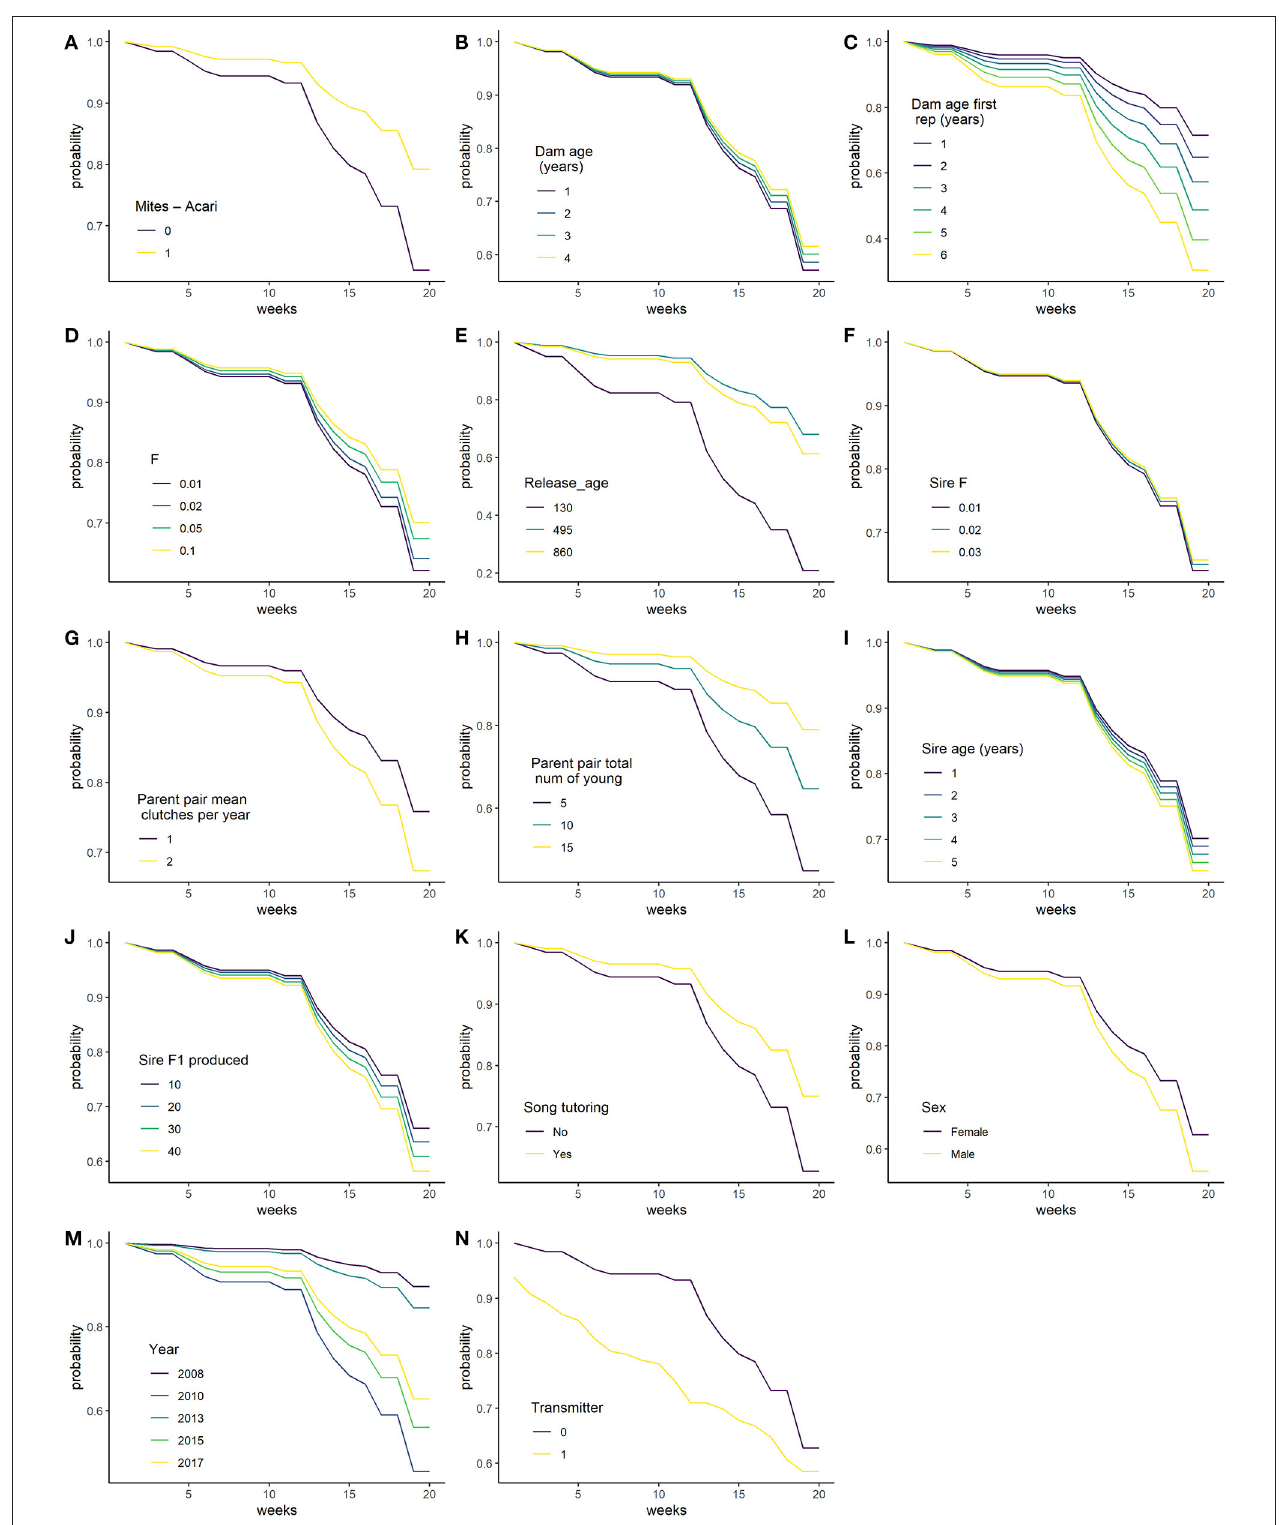
FIGURE 2 | Predicted survival probability of released bird in weeks 1–20, changing each variable in turn, while holding all other continuous variables at their mean and categorical variables at their reference level. (A) Mites - Acari; (B) Dam age (years); (C) Dam age at first reproduction (years); (D) F in breeding coefficient; (E) Release_age (days); (F) Sire F; (G) Parent pair mean clutches per year; (H) Parent pair total number of young; (I) Sire age (years); (J) Sire F1 produced; (K) Song tutoring; (L) Sex; (M) Year; and (N) Transmitter.